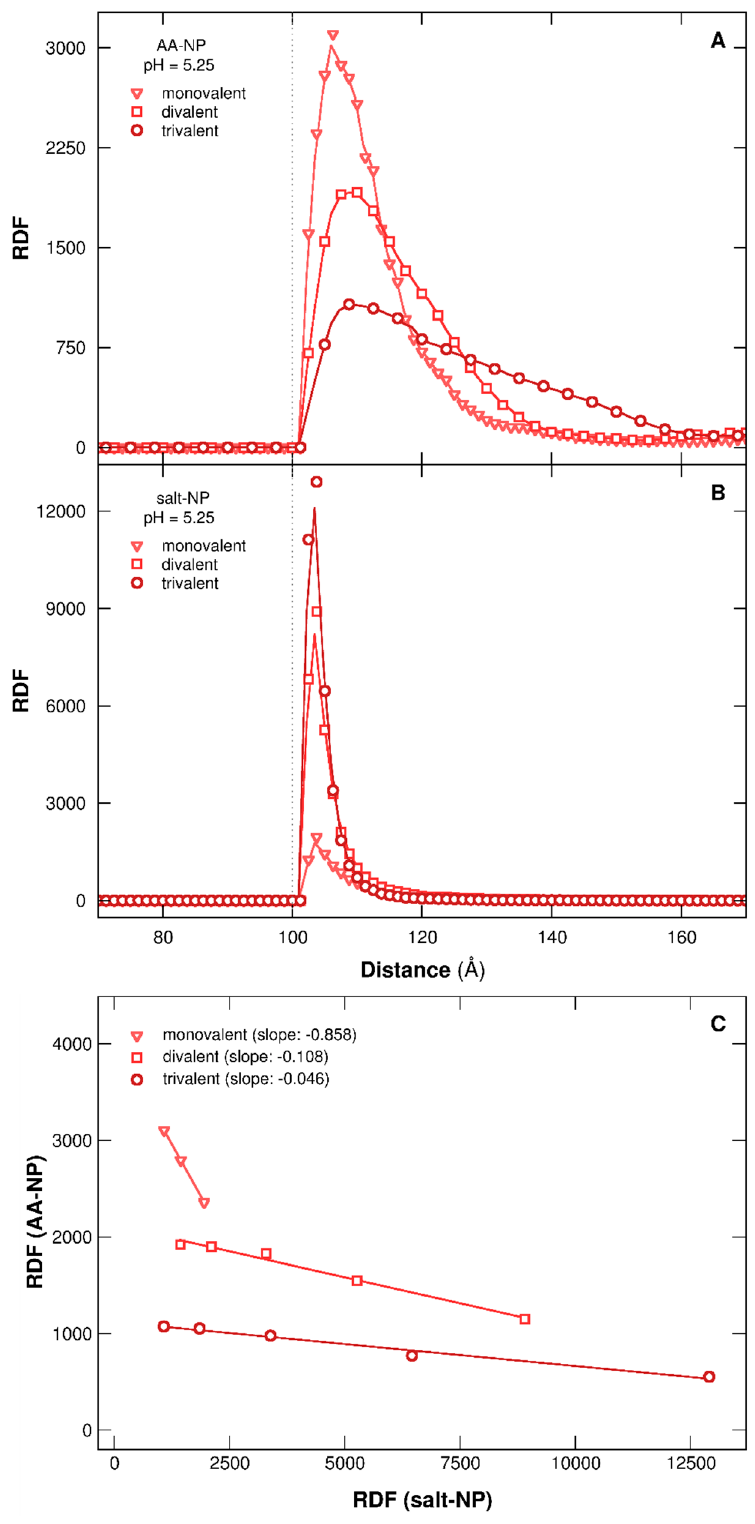
Figure 8. RDFs of ( A ) chain AAs and ( B ) salt cations around the NP surface ( σ = − 60 mC/m 2 ) at pH 5.25. ( C ) represents the AA density as a function of salt cation density. Monovalent, divalent, or trivalent salts (ionic strength 1 × 10 − 4 M) are considered. Dotted lines represent the NP radius (100 Å).